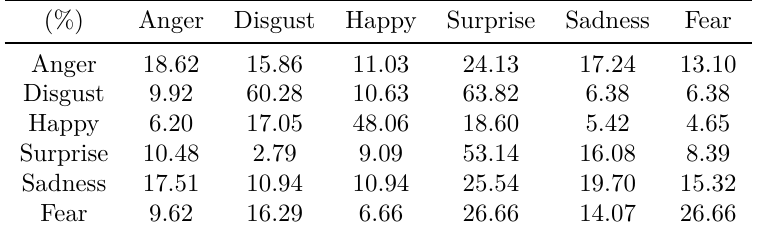
Table 2. Confusion matrix of the best HMM facial expression classifier using LBP features.